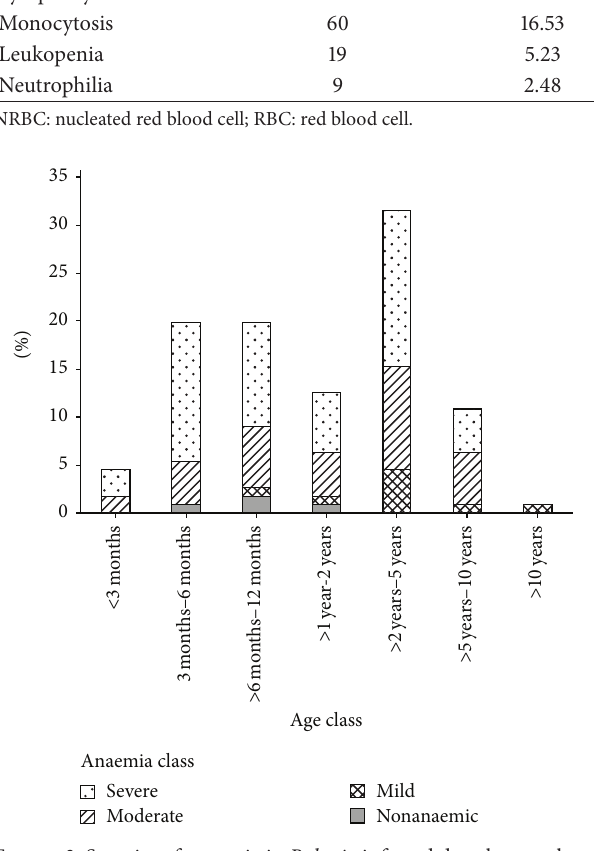
Figure 3: Severity of anaemia in Babesia infected dogs by age class. Anaemia was classified as severely anaemic (PCV less than 15%); moderately anaemic (PCV 15–30); mildly anaemic, (PCV > 30–37); and nonanaemic (PCV > 37%).